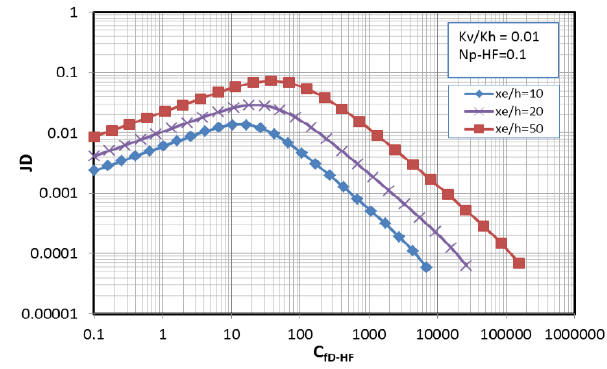
/k = 10 and proppant number from 0.00001 to 100. v h